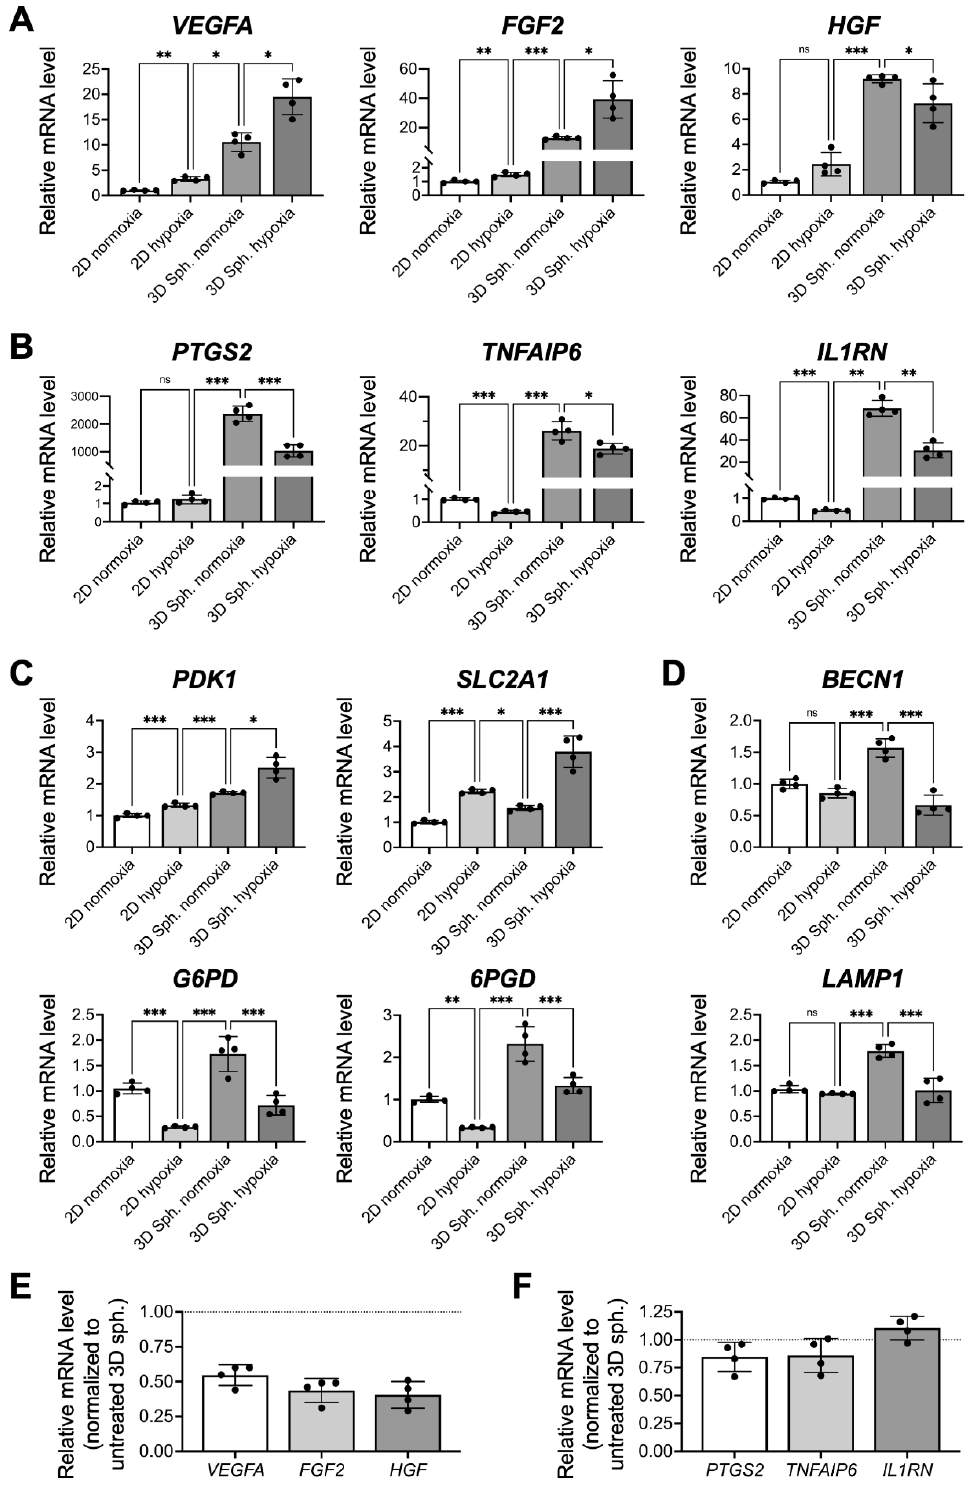
Figure 4. The enhanced therapeutic potential of MSCs after assembly into a 3D spheroid configuration is not fully attributed to the development of a hypoxic niche. The mRNA levels of genes that encode ( A ) paracrine signaling molecules, ( B ) immunomodulatory enzymes/cytokines, ( C ) metabolic enzymes/transporters and ( D ) autophagic markers in MSCs grown in 2D or 3D configurations under normoxic or hypoxic conditions were explored ( n = 4). ( E ) Relative gene expression of paracrine signaling molecules or ( F ) immunomodulatory enzymes/cytokines after glycolytic inhibition using 5 mM 2-deoxyglucose ( n = 4). * p < 0.05; ** p < 0.01; *** p < 0.001; ns: not significant.